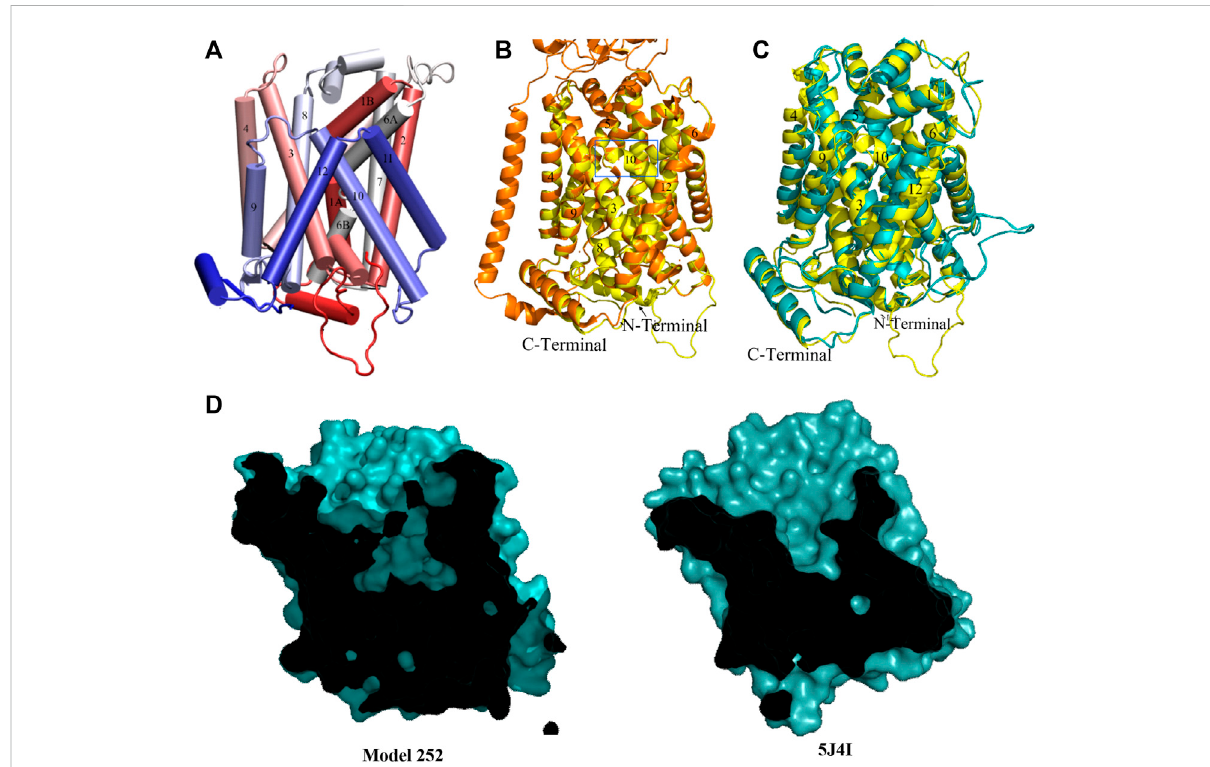
FIGURE 5 (A) Homology model of model 252. (B) Overlay of model 252 (yellow) and Cryo-EM outward-occluded structures of human LAT1 with bound inhibitor JX-078 (PDB code: 7DSL, orange) from intracellular side from extracellular side. The most different region (TM10) between two structures remarked in the blue box. (C) Overlay of model 252 (yellow) and model 140 (cyan). (D) Sliced-surface representations of the model 252 and AdiC outward-open substrate-free structure